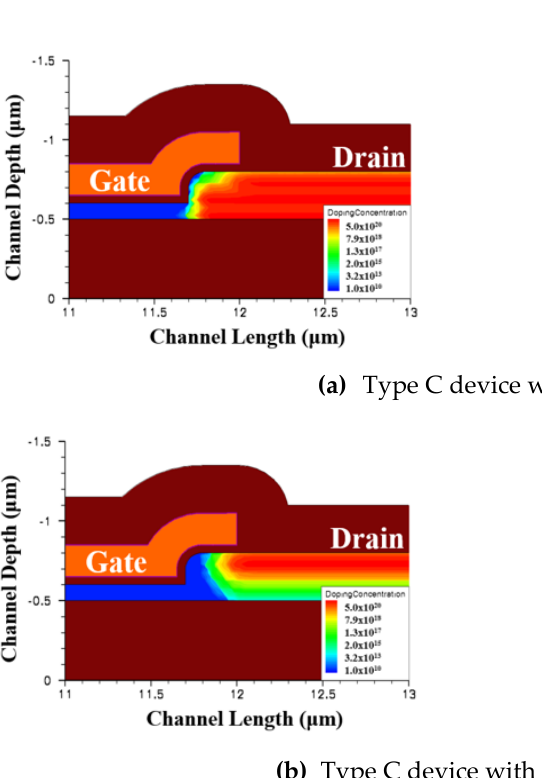
Figure 7. Drain doping concentration profiles and electric field distributions of type C device with uniform doping drain (UDD) (a) and vertical lightly doped drain (LDD) structures (b) (V GS = 5 V and V DS = 8 V).